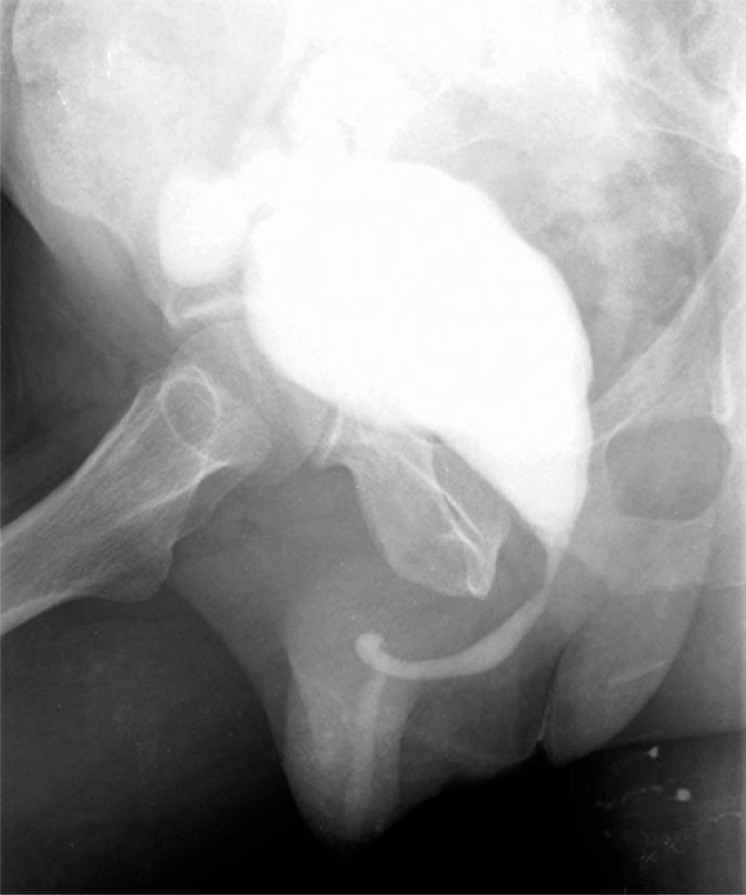
Uretrocistografia. Neobexiga em pós-operatório tardio